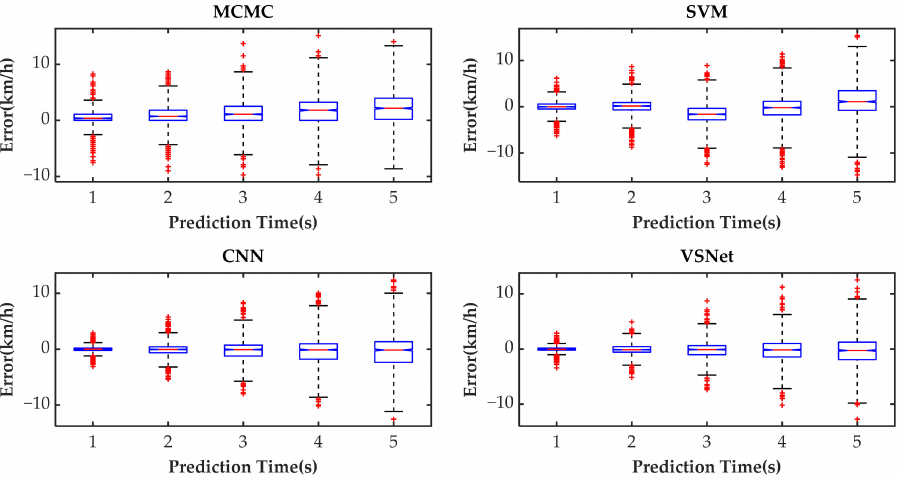
Figure 17. The box plots of the speed prediction errors.